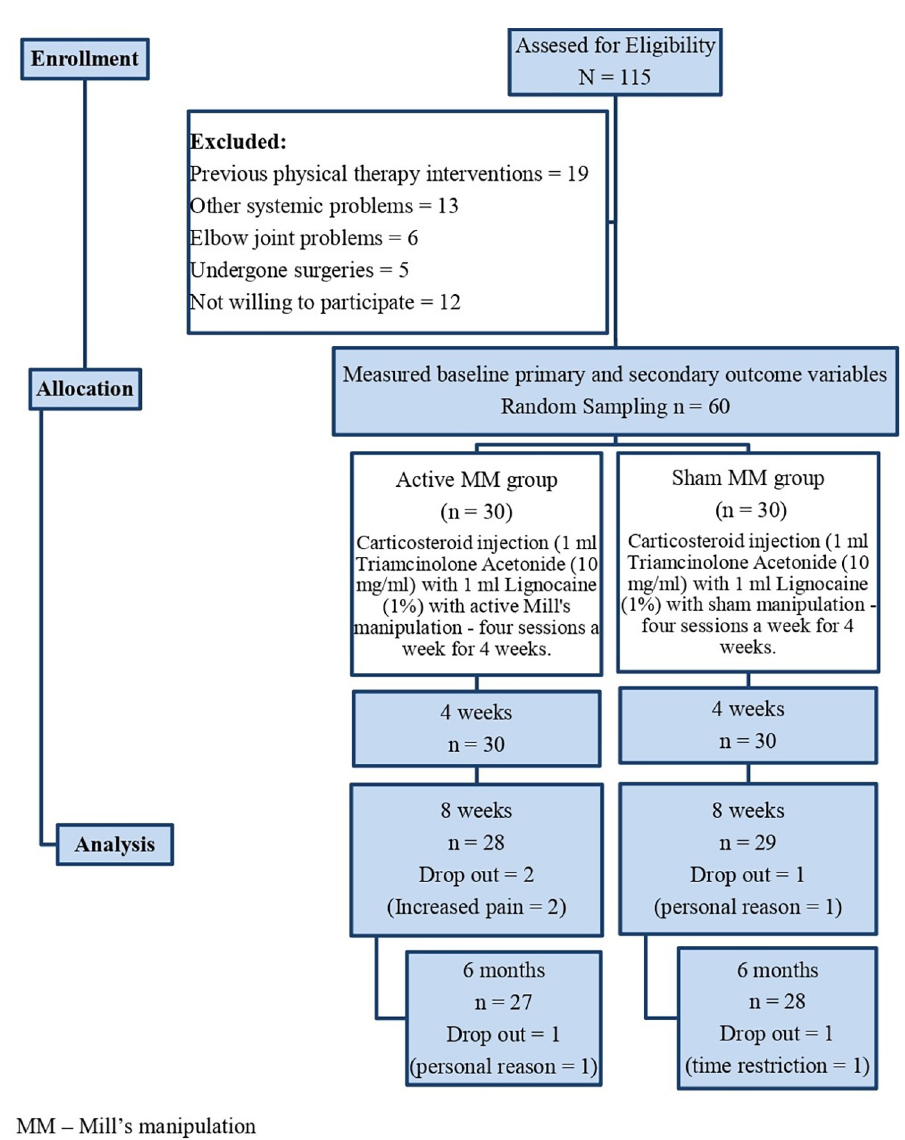
Fig 1. Flow chart showing the study